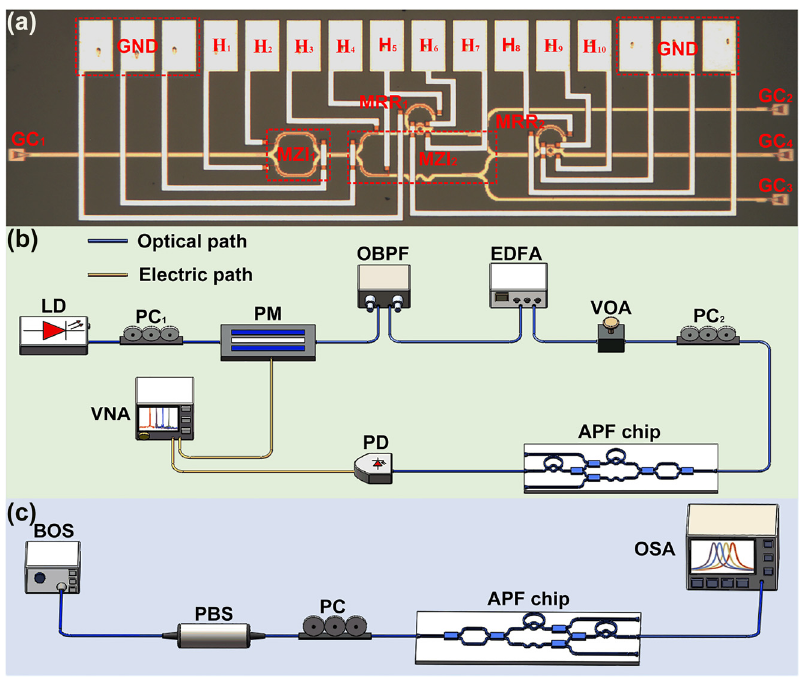
Figure 4: Fabricated device and measurements. (a) Optical micrograph of the fabricated device. (b) Experimental setup for measuring the frequency response and time delay of